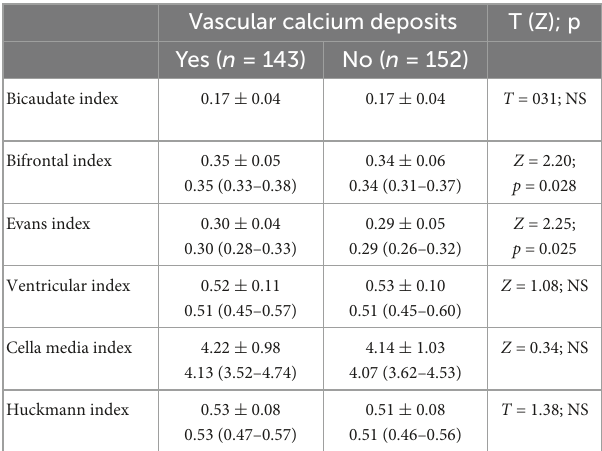
TABLE 3 Vascular calcium deposits and CT indices.